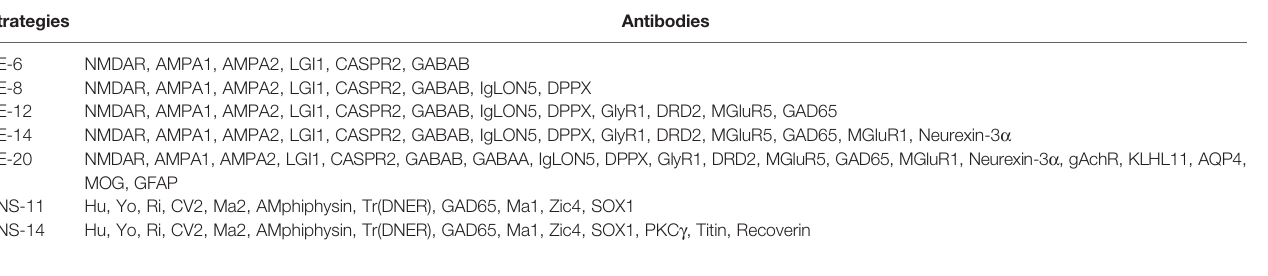
TABLE 1 | Different detection strategies for anti-neuronal antibodies in Guizhou KingMed.